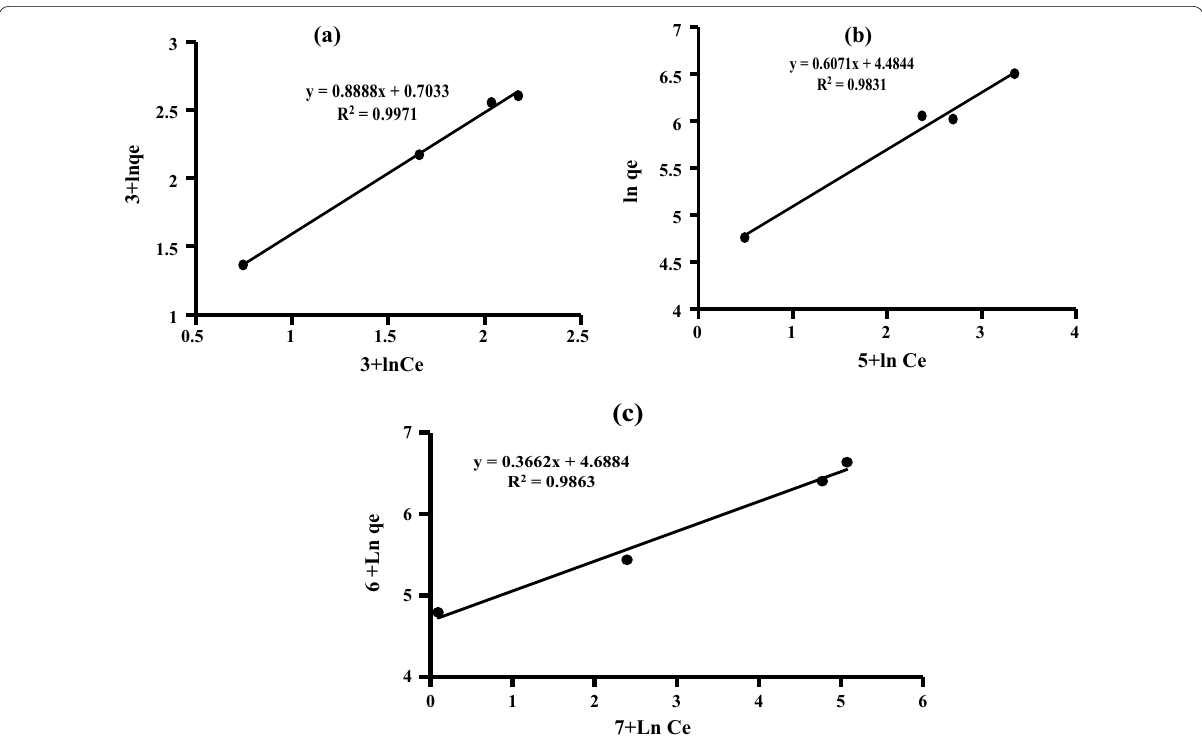
Fig. 11 Freundlich isotherm of copolymer ( a ), aniline graft ( b ) and 2‑chloroaniline graft ( c